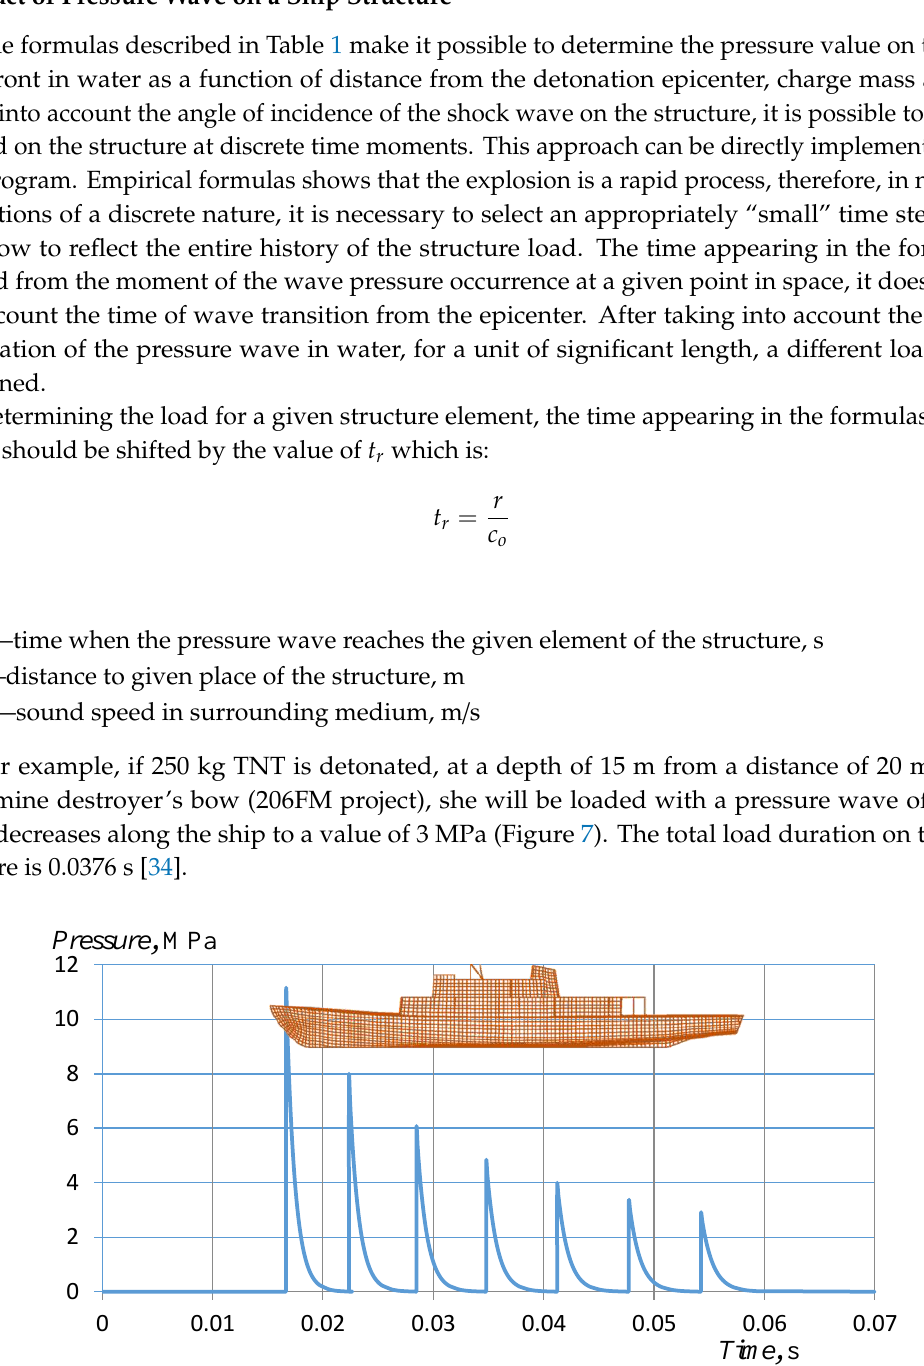
Figure 7. Propagation of pressure wave along the ship, detonation of 250 kg of TNT at a distance of 20 m in front of the ship, at a depth of 15 m [34]. A significant drop in the pressure wave value between the bow and the stern is noticeable.